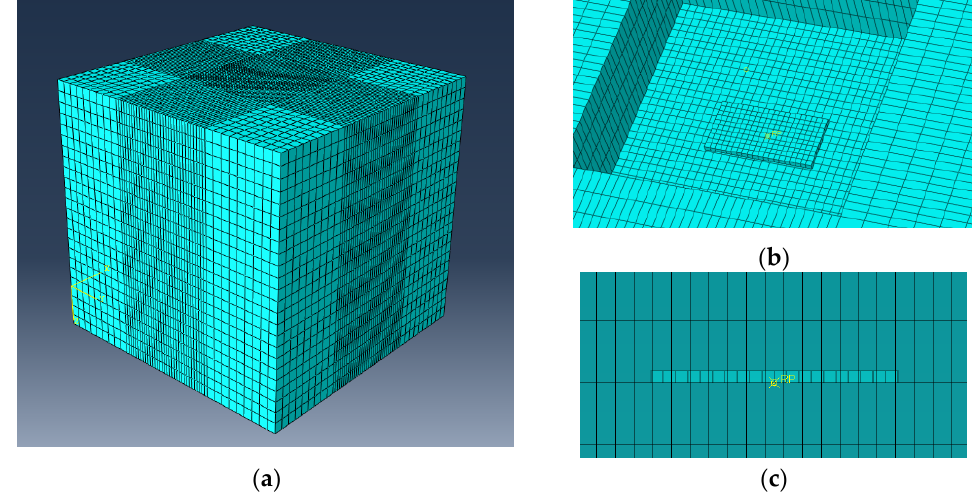
( b ) ( c ) Figure 9. Sensitivity analysis results of each mesh seed. ( a ) Zone-1, ( b ) Zone-2, ( c ) Zone-3. Table 8. The mesh seed value.